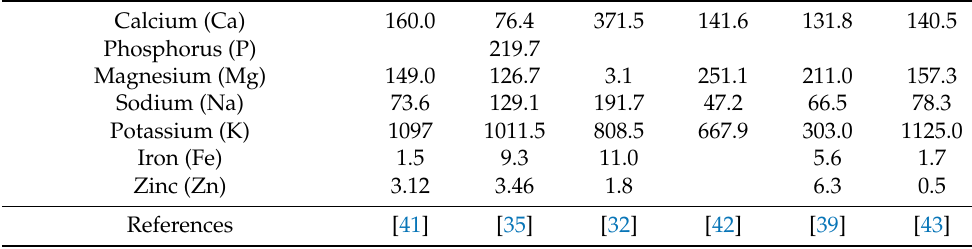
Table 3. Mineral content of tomato pomace (g/kg dry matter